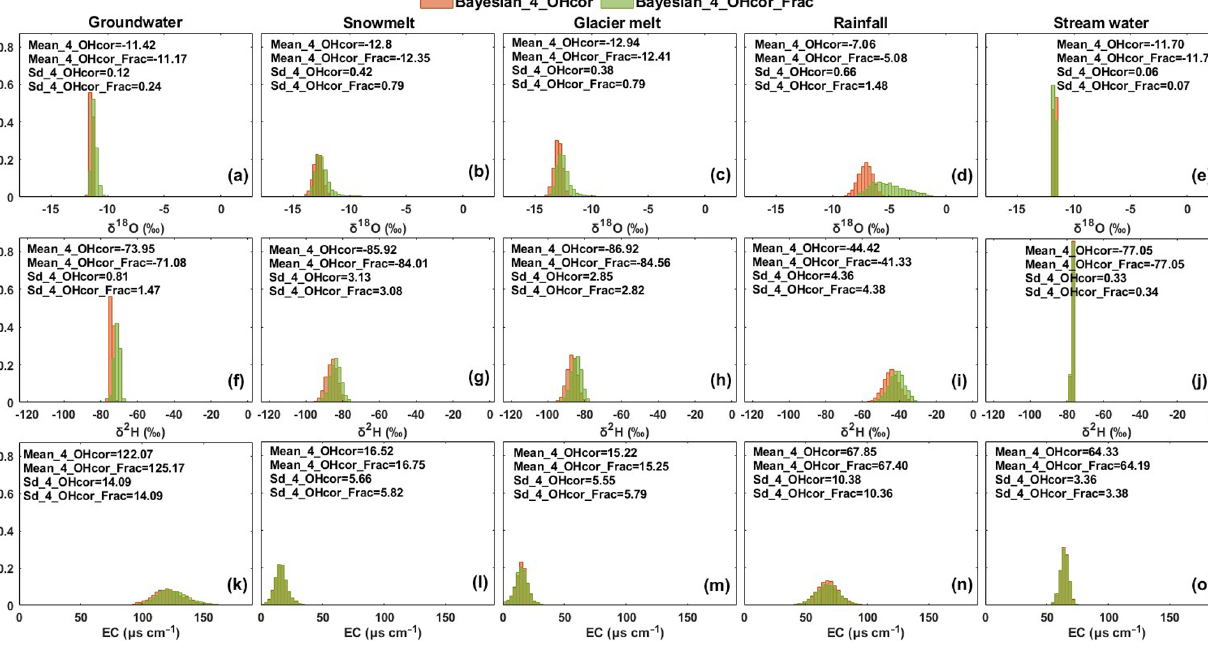
Figure 10. Effects of isotope fractionation on the estimated posterior distributions of tracer signatures of water sources in the glacier melt